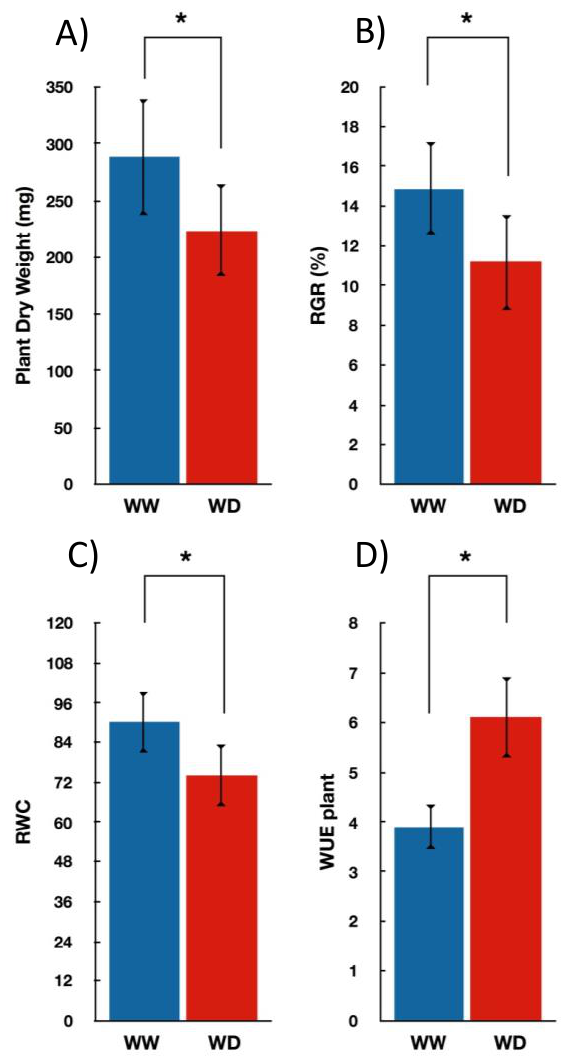
Figure 3. ( A ) Seedlings DW (dry weight), ( B ) RGR, ( C ) RWC and ( D ) WUE plant on the seventh day of the experiment. Blue bars represent well-watered seedlings; red bars represent water-deficit treated seedlings. * means p value < 0.05.